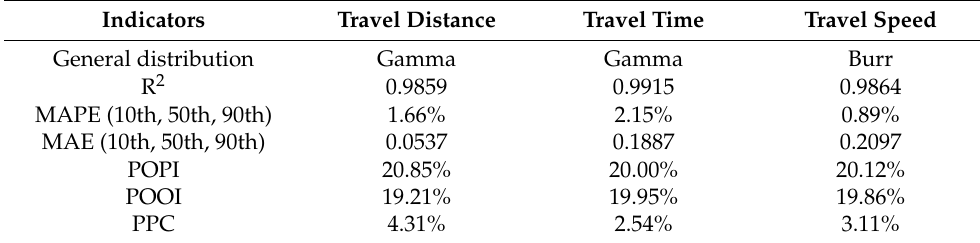
Table 6. Evaluation of general distribution for three trip metrics. Indicators Travel